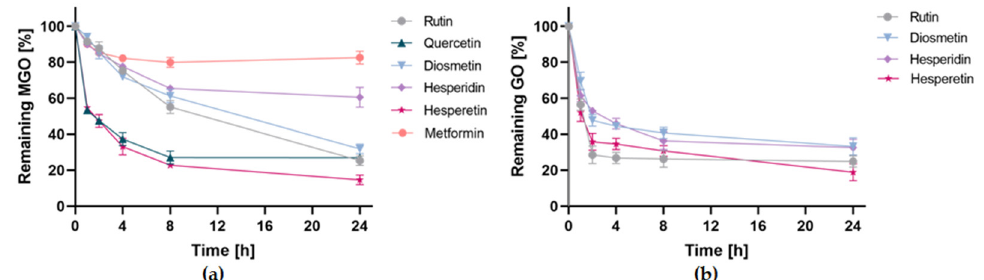
Figure 10. RCS trapping efficiency of tested compounds in pH 7.4 phosphate buffer solution at 37 °C for 1, 2, 4, 8, and 24 h expressed as % of remaining MGO/GO; ( a ) reaction with methylglyoxal; ( b ) reaction with glyoxal. All data are presented as means ± SD (n =